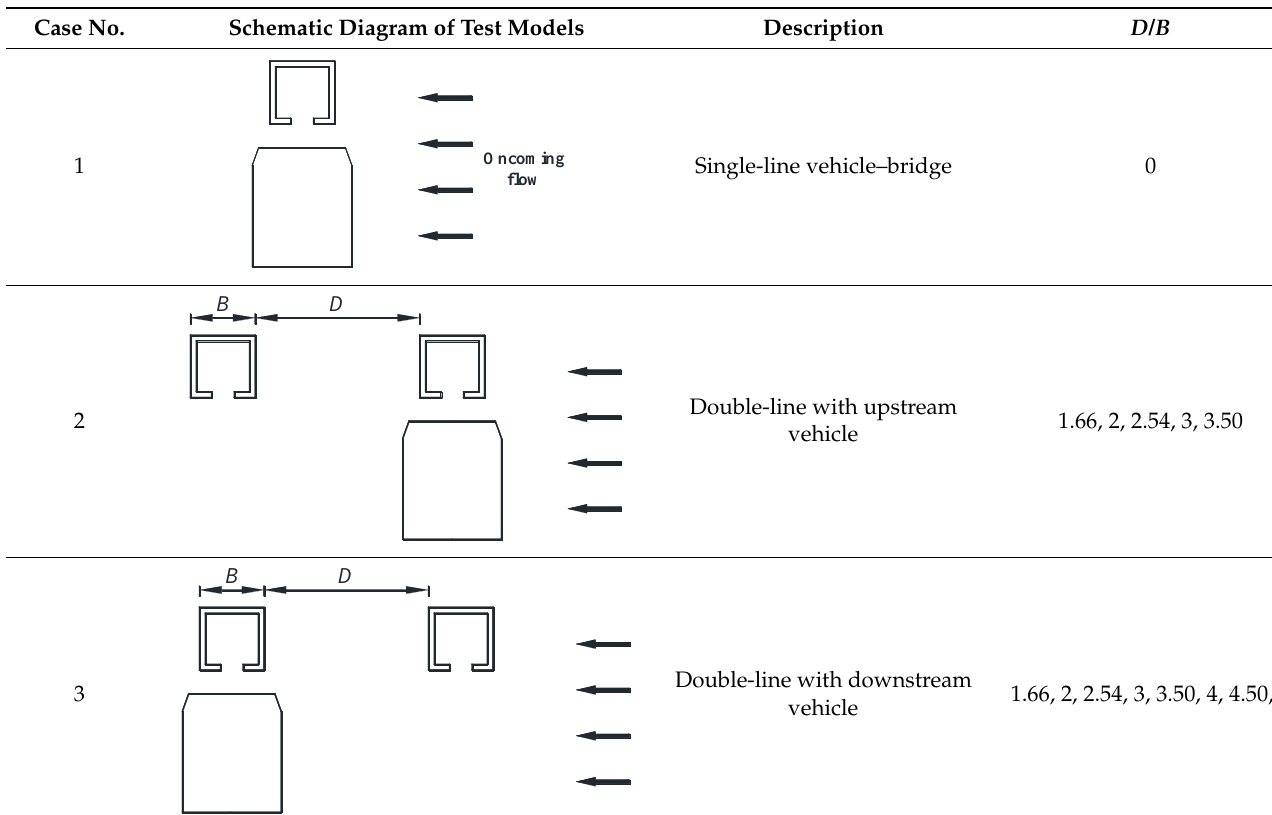
Table 1. Testing cases.